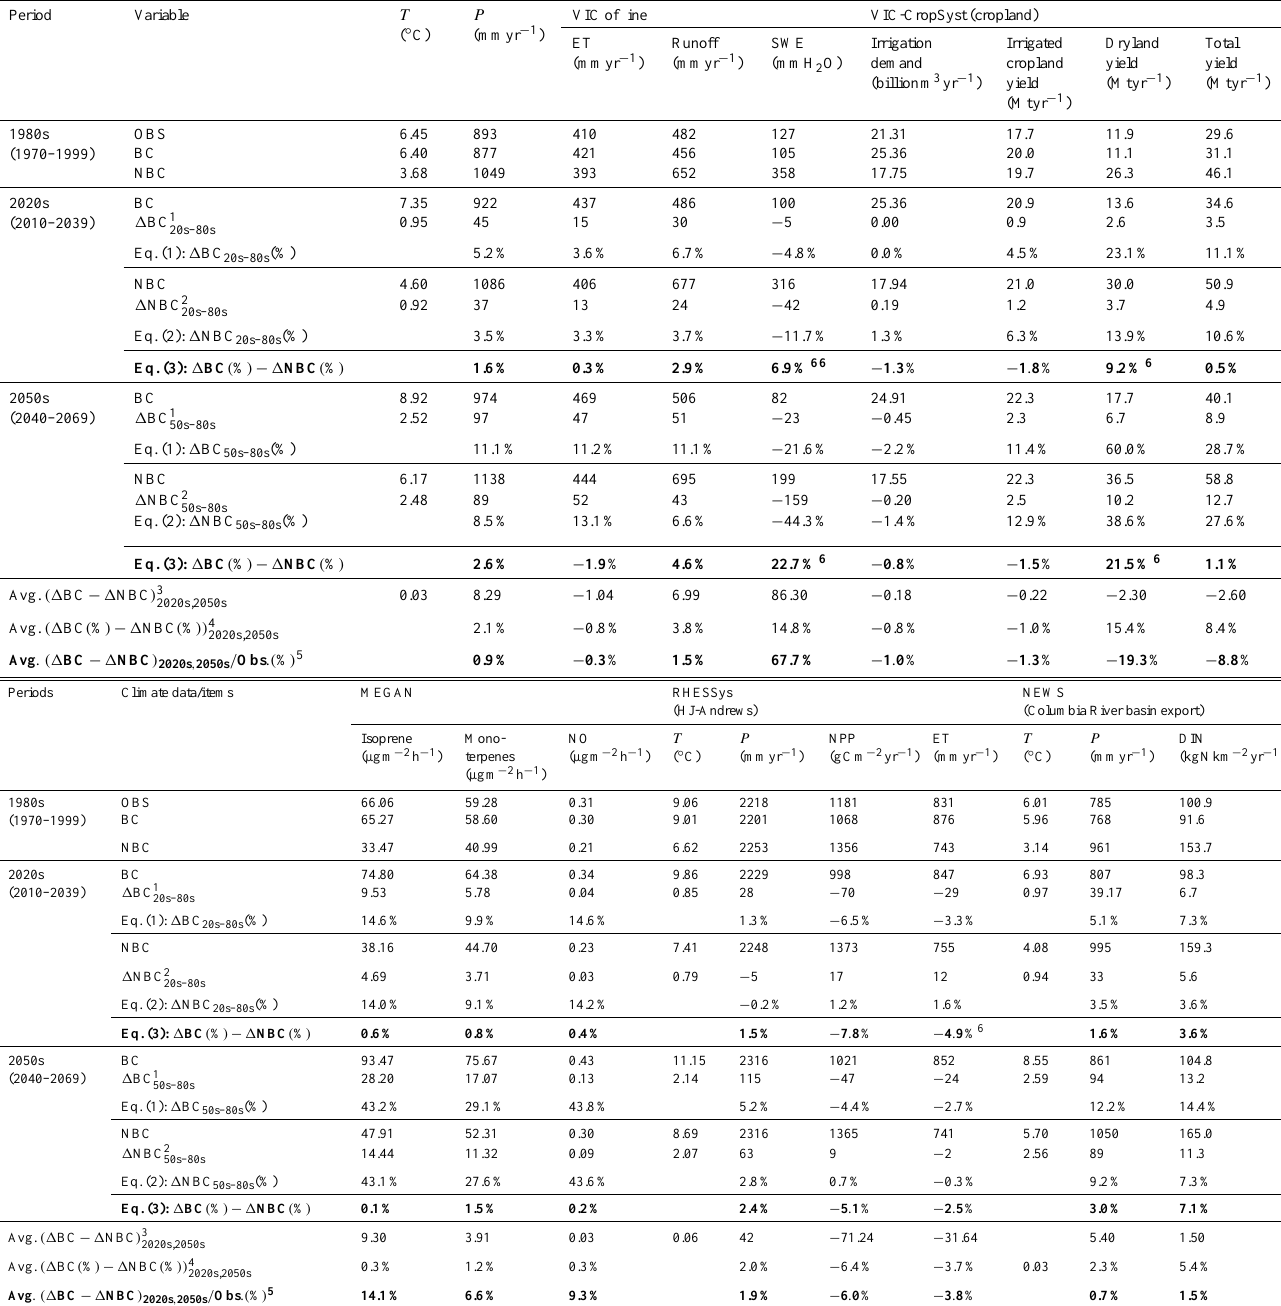
Table 2. Changes in climate and simulated variables during the periods of 1980s–2020s and 1980s–2050s, and differences in the changes between results with bias correction (BC) and without bias correction (NBC) of climate